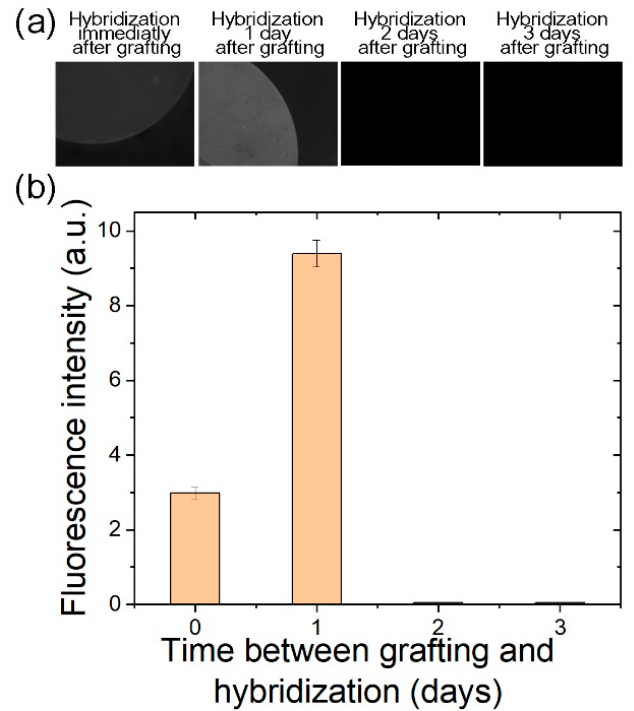
Figure 8. Fluorescence intensity as a function of delay between TBA–15 probe grafting and hybridization when Si / SiO 2 (100 nm) substrates functionalized by UV-assisted GOPS protocol are kept in ambient conditions. ( a ) Typical epifluorescence microscopy images when the hybridization with the complementary strand (cTBA) was conducted at di ff erent times after the TBA–15 grafting (immediately after, 1 day, 2 days, and 3 days after). ( b ) Fluorescence intensity, as measured on fluorescence micrographs, as a function of delay between TBA–15 probe grafting and hybridization. For all conditions, three fluorescent spots on the substrate were analyzed giving an average fluorescence intensity value and error bars corresponding to the minimum and maximum fluorescence intensity found for each sample.